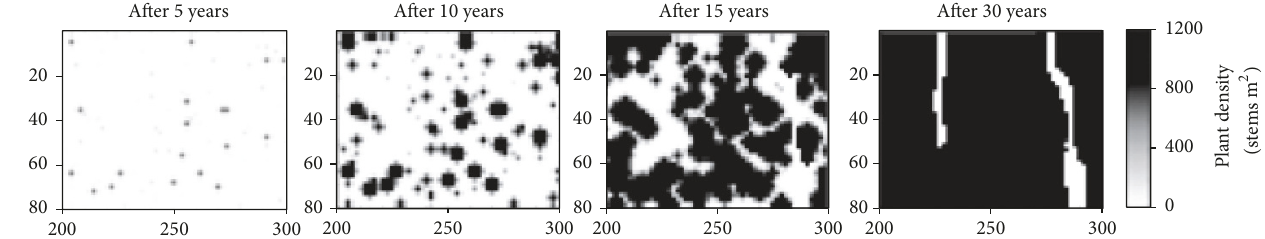
Figure 3: Example outputs of a dynamic ecological model at different time stamps